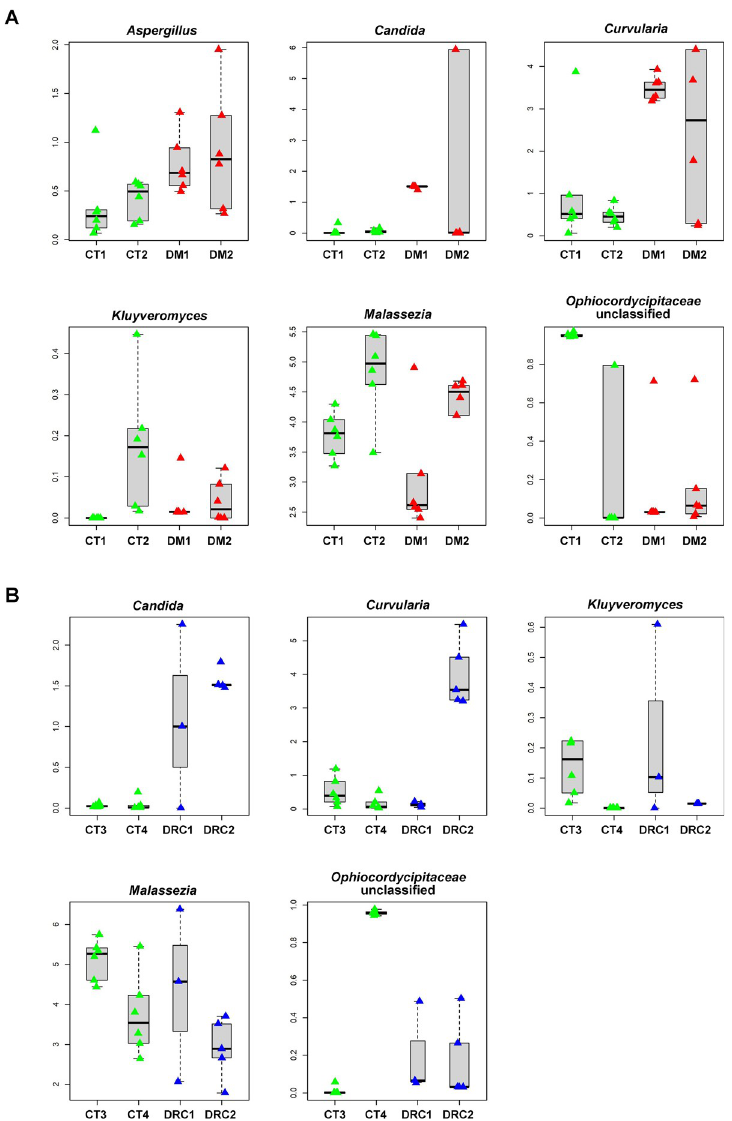
Fig 4. Box plots of genera exhibiting significant (p value < 0.05) differential abundance in gut mycobiomes of control (CT1, n = 6; CT2, n = 6) and diabetic (DM1, n = 6; DM2, n = 6) rats (A) and control (CT3, n = 6 and CT4, n = 6), and diabetic rats showing retinal changes (DRC1, n = 3 and DRC2 n = 5) (B) . Differentially only genera having a median abundance of > 0.05% in at least one group of samples and significantly different in abundance have been depicted. Median abundances (horizontal line) and inter-quartile ranges are indicated in the